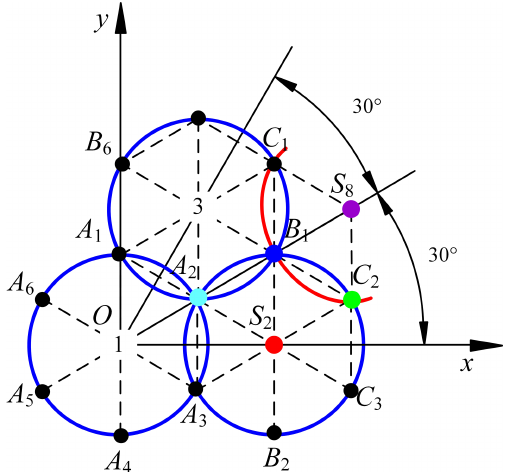
Figure 15. Schematic diagram of the key